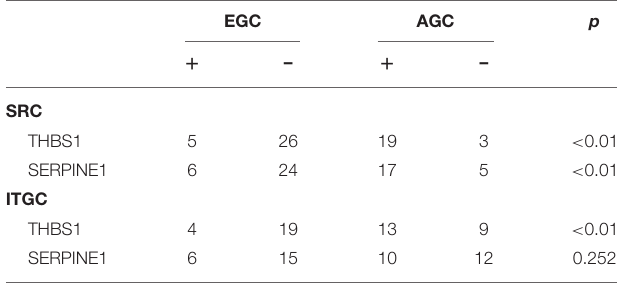
TABLE 5 | Expression of THBS1 and SERPINE1 in signet-ring cell carcinoma and non-signet ring cell carcinoma. SRC